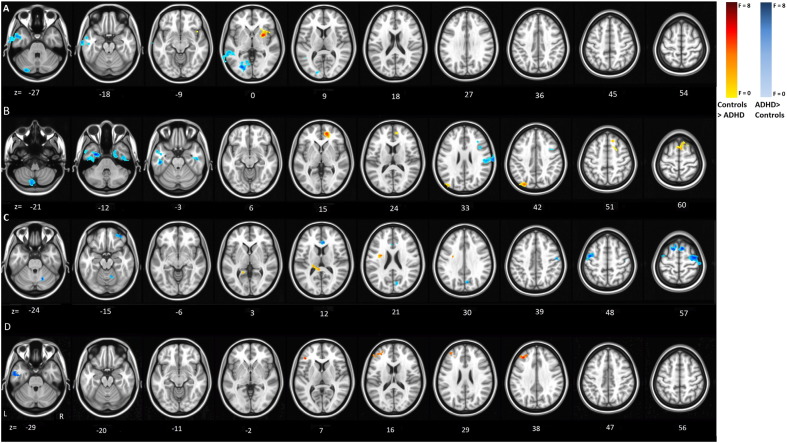
Differences in functional connectivity based on F-test comparing all three diagnostic groups. Connectivity patterns depicted from the inferior frontal seed region, in the successful stop condition (A) and the failed stop condition (B); as well as from the superior frontal seed region, in the successful stop condition (C) and the failed stop condition (D). Red hues indicate significantly higher connectivity in controls; blue hues indicate higher connectivity in ADHD subjects or unaffected siblings.